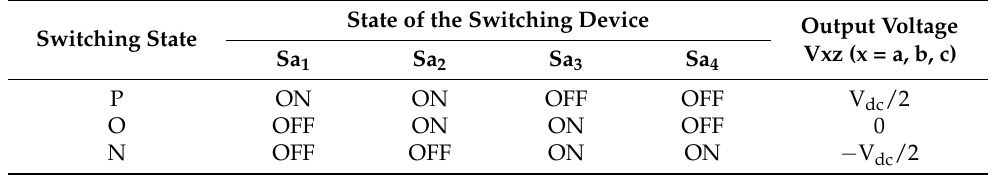
Table 3. Inverter switching states.